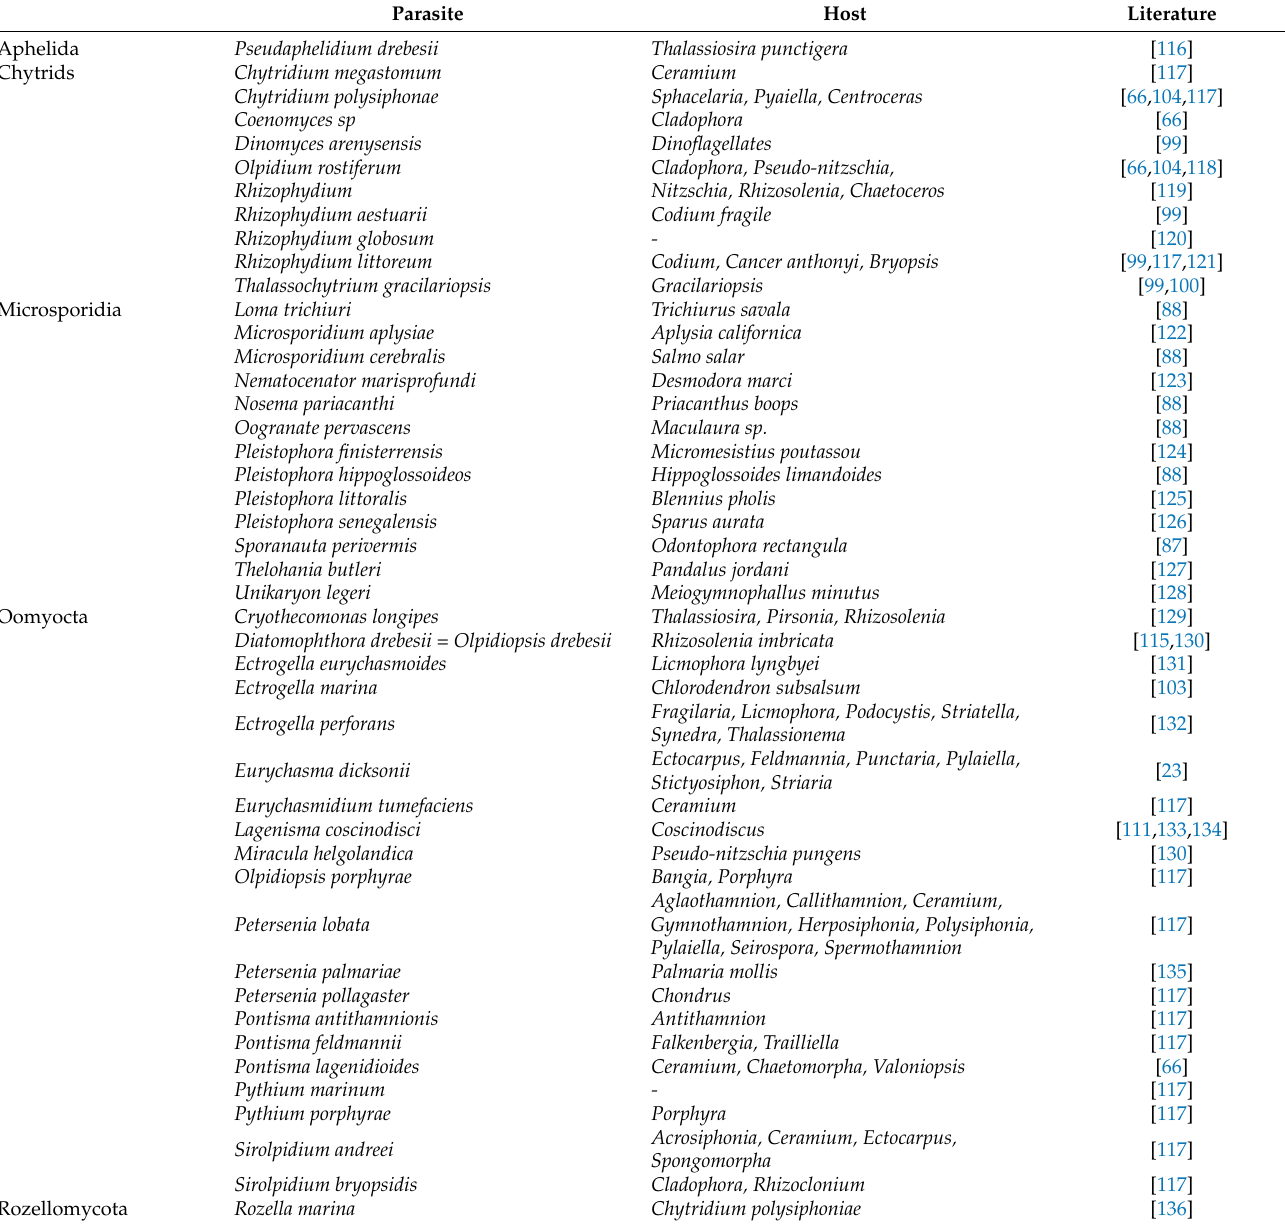
Table 1. Overview of marine parasites belonging to basal fungal phyla and their